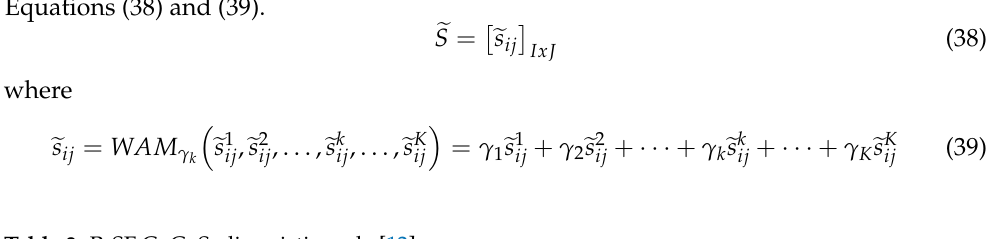
Table 3. R-SF CoCoSo linguistic scale